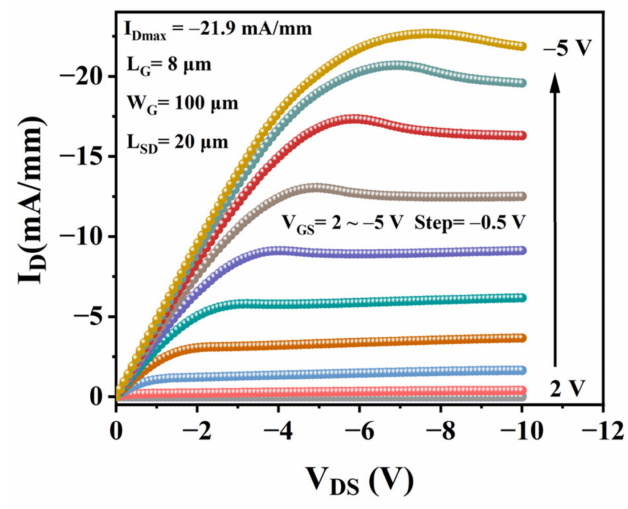
Figure 5. I DS -V DS characteristic of SnO x /H-diamond based FET.